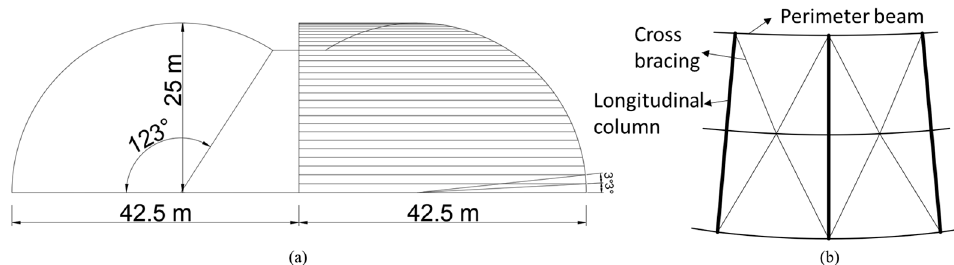
Figure 3. Schematic design of the model: ( a ) front view of the half-structure; ( b ) structural member demonstration.